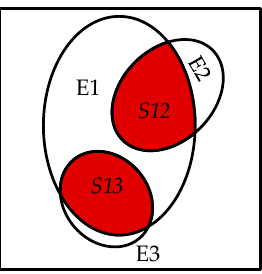
Figure 7. A diagram depicting area overlap ratio, where r2 ≥ 2/3 and r3 ≥ 2/3.